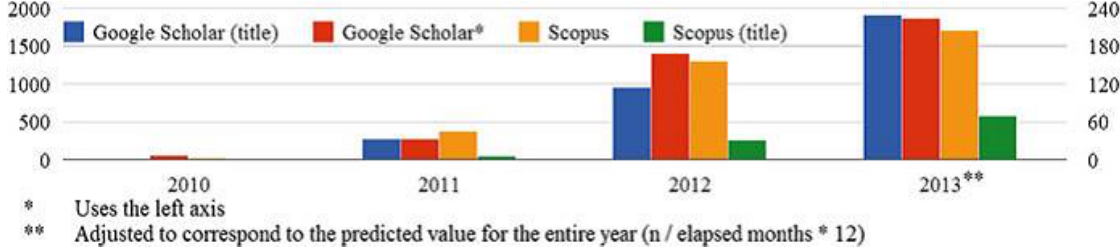
Figure 5. Search hits for